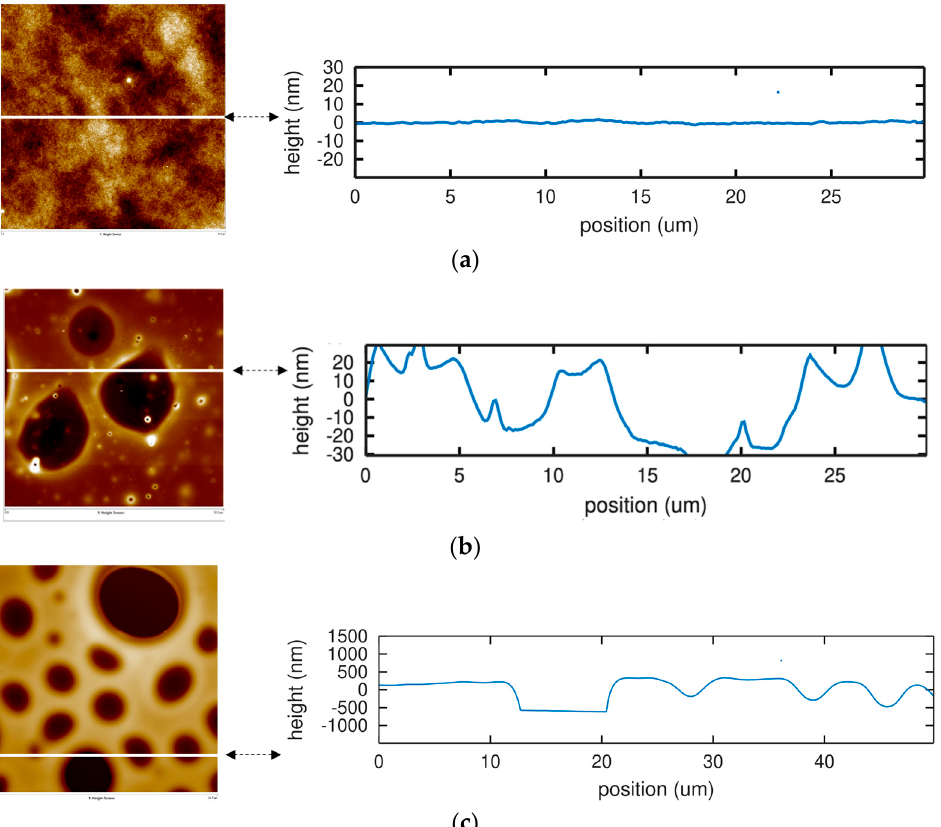
Figure 5. AFM topography scans (left) and corresponding height profile along the white line (right) of a silicon surface covered with a layer of PBMA (thickness: 500 nm). ( a ) Flat surface after deposition of PBMA by spin-coating. ( b ) The surface is still quite flat (RMS roughness: 11.3 nm) after immersion in water-acetonitrile (96:4) solution for 12 h despite some roughness increase with respect to ( a ). ( c ) After immersion in a water-acetonitrile solution of chlorpyrifos for 12 h then rinsed for 1 h with an acetonitrile-water solution (96:4), the surface of PBMA layer shows deep (200 nm) and crossing (500 nm) holes.